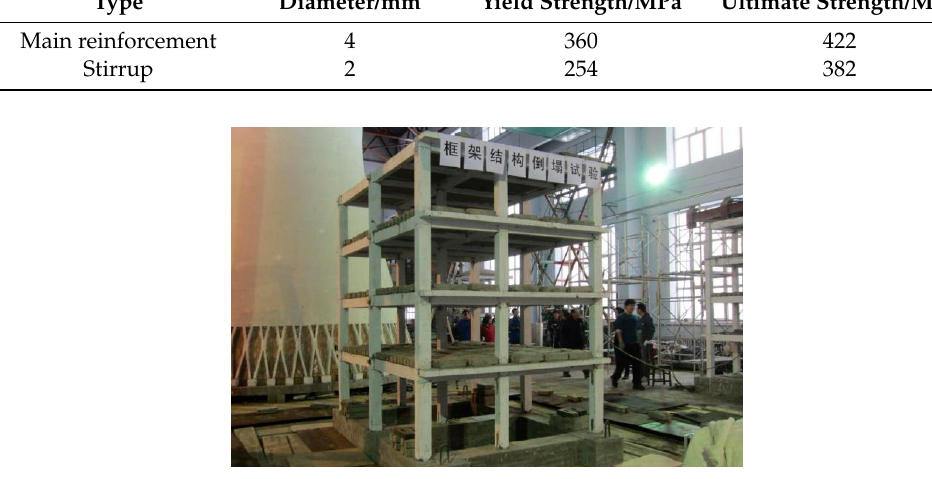
Figure 3. Overview of the test model.